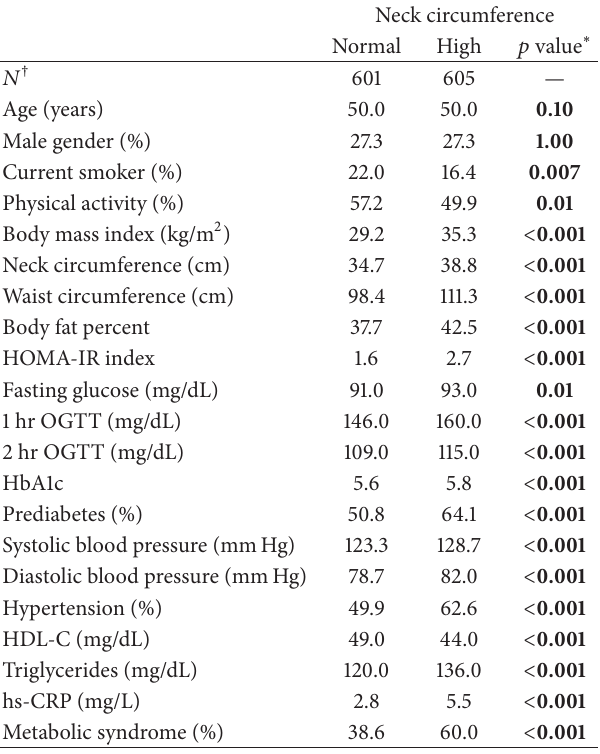
Table 1: Baseline characteristics according to neck circumference categories.